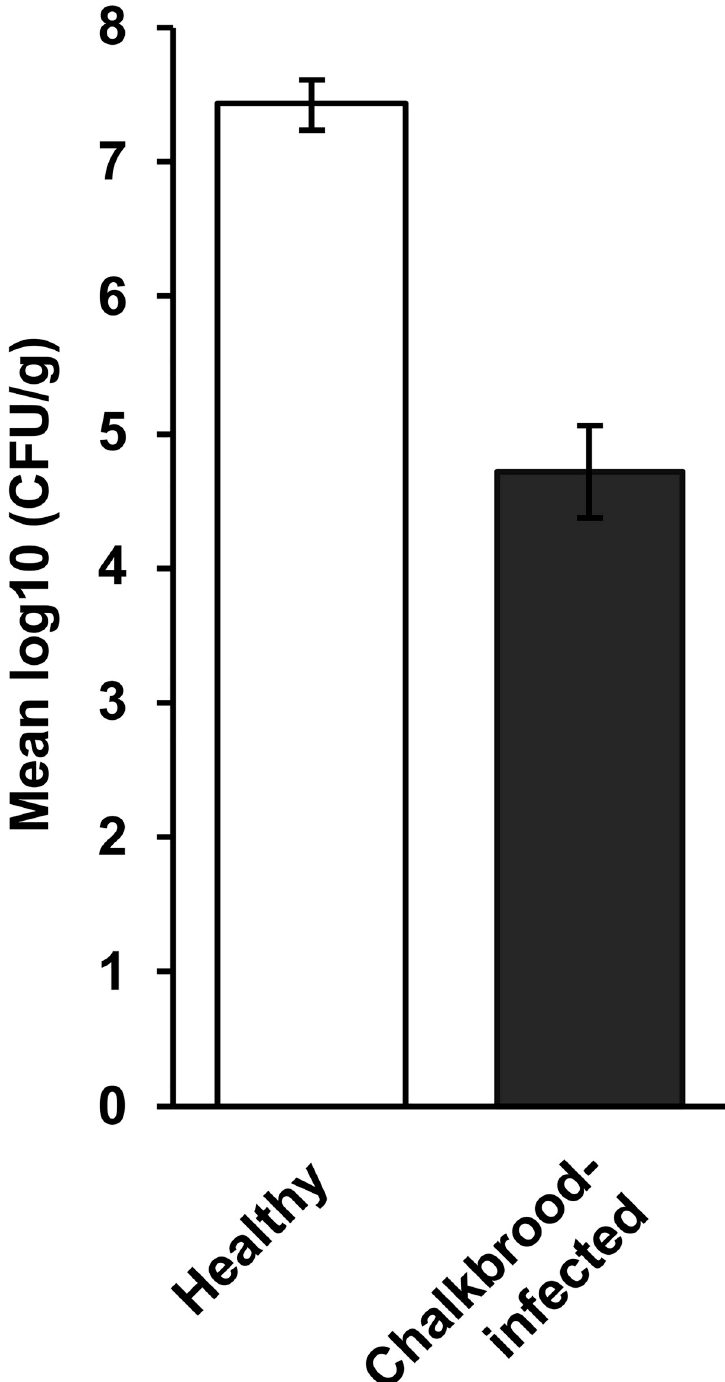
Fig 2. Aerobic gut bacterial numbers (CFU/g) in nurse bees from healthy hives ( n = 47) and chalkbrood-infected hives ( n = 31). Bees were collected from around Australia. The difference between the two groups is statistically significant ( P < 0.001). Error bars represent the standard error of the mean (SEM) with a 5% least significant difference (LSD) level of 0.716.